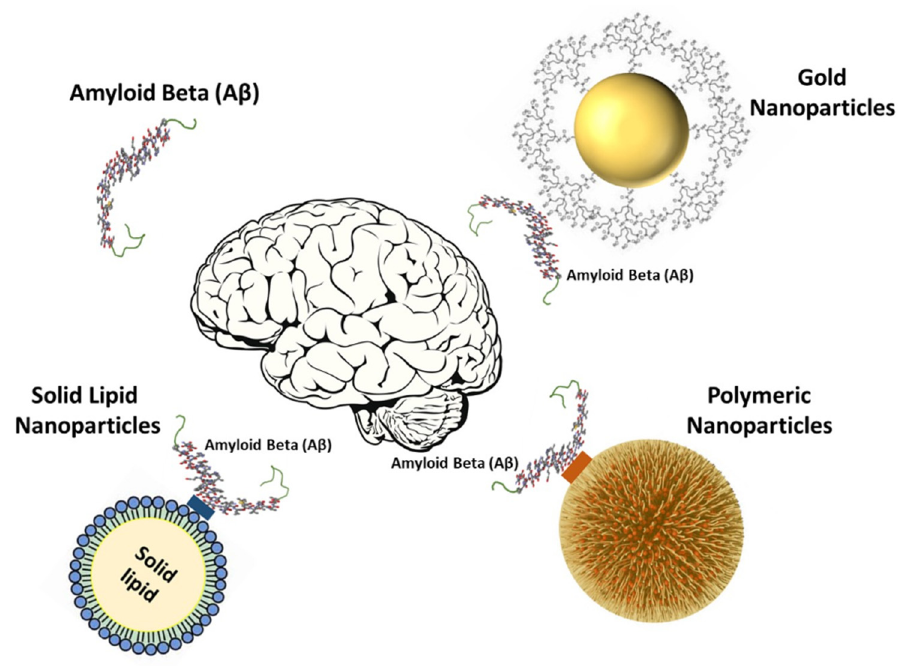
Figure 1. Effects of different types of nanoparticles on the treatment of Alzheimer’s disease